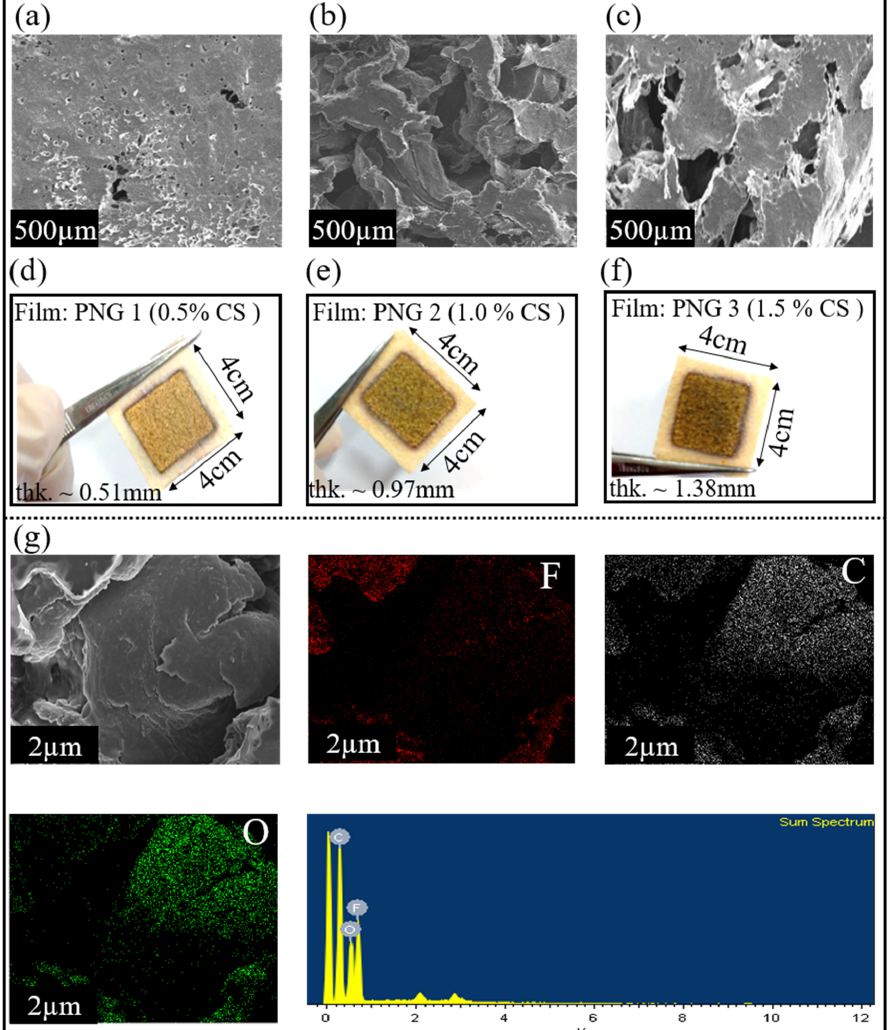
Figure 2. SEM images, digital photographs and EDS mapping of CS ‐ PVDF ‐ based composite films ( a ) 0.5% CS ‐ PVDF, ( b ) 1.0% CS ‐ PVDF, ( c ) 1.5% CS ‐ PVDF, ( d ) 0.5% CS ‐ PVDF film used in PNG 1 device, ( e ) 1.0% CS ‐ PVDF film used in PNG 2 device, ( f ) 1.5% CS ‐ PVDF film used in PNG 3 device, and ( g ) EDS maps for F, N, and O in 1% CS ‐ PVDF film. Similarly, the surface morphologies of the pure PVA and composite (CS ‐ PVA) films were investigated using scanning electron microscopy (SEM). From the SEM results shown in Figure 3, it can be observed that CS ‐ PVA composite with 70/30 of volume ratio (Figure 3c) have good microstructure compared to the rest of the CS ‐ PVA composites with volume ratio of 90/10, 50/50 and 40/60. This means that there is an optimum CS ‐ PVA vol ‐ ume ratio that improves the mixing of chitosan and PVA with good microstructure. The EDS analysis shows the elemental composition, which is uniformly distributed over the entire surface of the CS ‐ PVA blend. The characteristic peaks of carbon (C), oxygen (O) and sodium (Na) elements owing to the CS ‐ PVA polymeric blend are shown in Figure 3f.